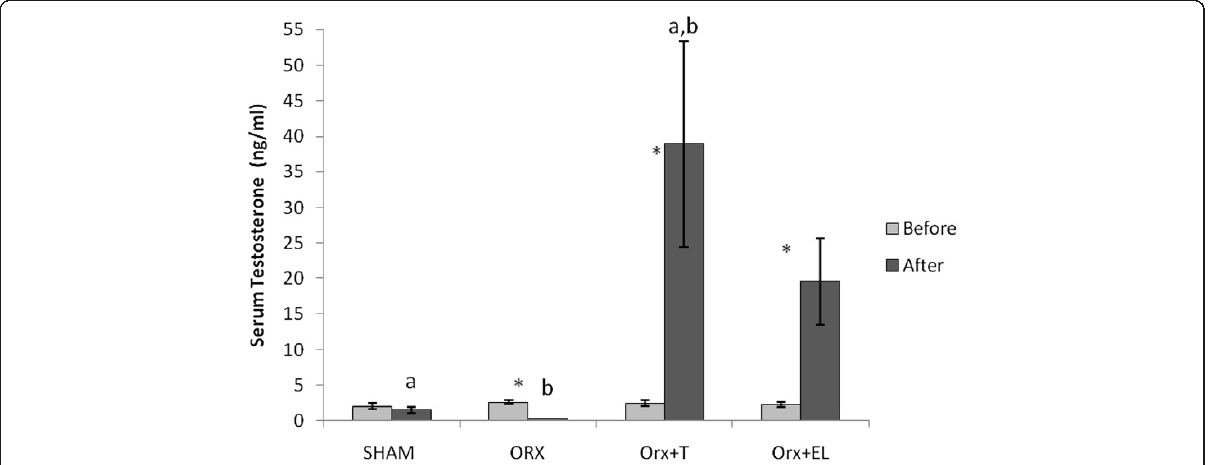
Figure 2 The testosterone levels before and after treatment. Data were presented as mean ± SEM with significant difference p < 0.05. *indicate significant difference before and after treatment. Same alphabet indicate significant difference between the groups after treatment. SHAM : Sham- operated group. ORX : Orchidectomized control group. ORX + T : Orchidectomized group treated by testosterone. ORX + EL : Orchidetctomized group treated with EL.